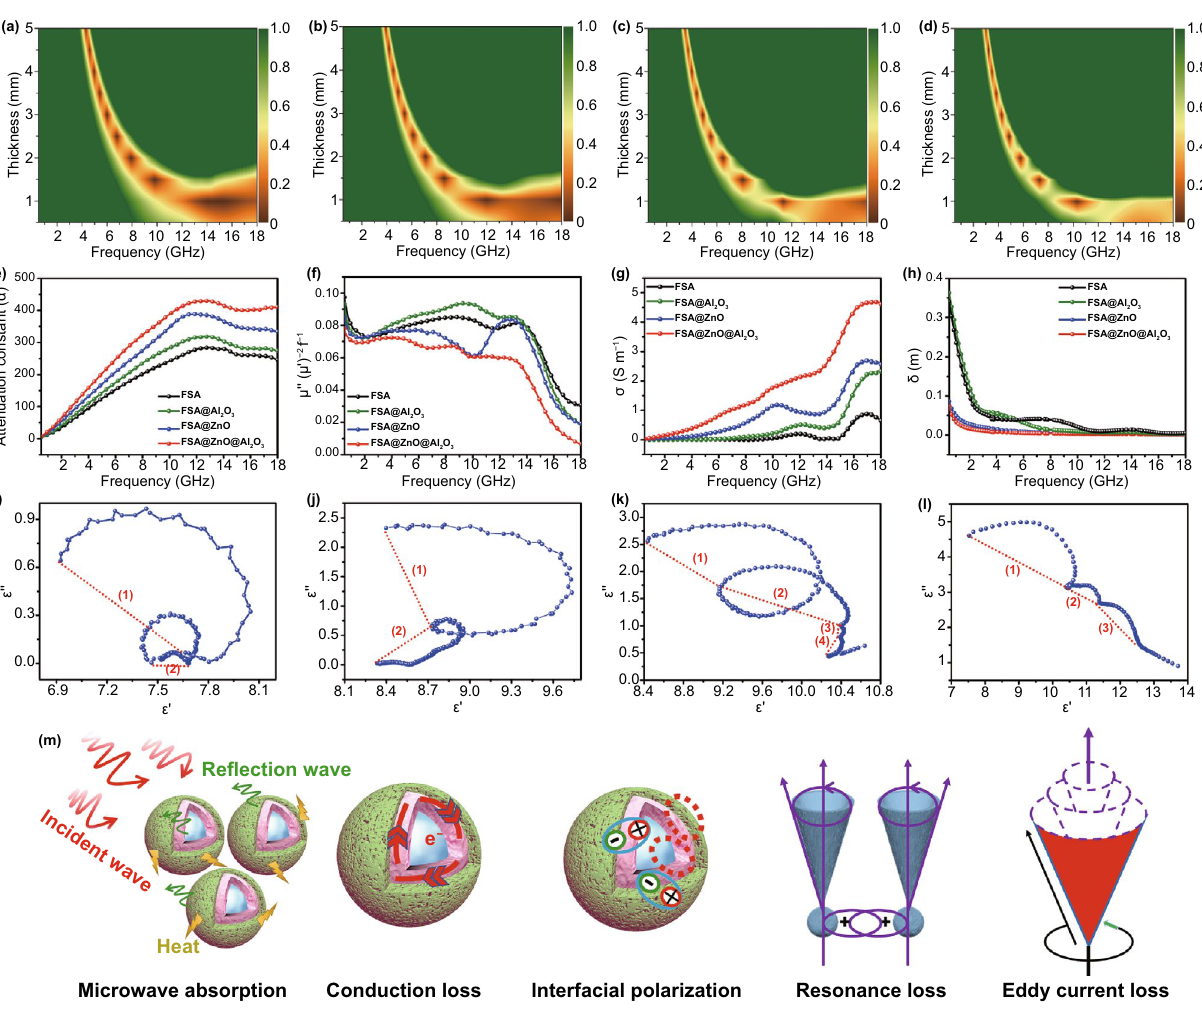
Fig. 4 Calculated delta value maps of a FSA, b FSA@Al 2 O 3 , c FSA@ZnO, d FSA@ZnO@Al 2 O 3 . e Attenuation constants, f curves of μ"(μ’) −2 f −1 vs f , g electrical conductivity (σ), h skin depth (δ) of FSA and FSA-based samples. Typical ε ′′ - ε ′ curves of four samples with